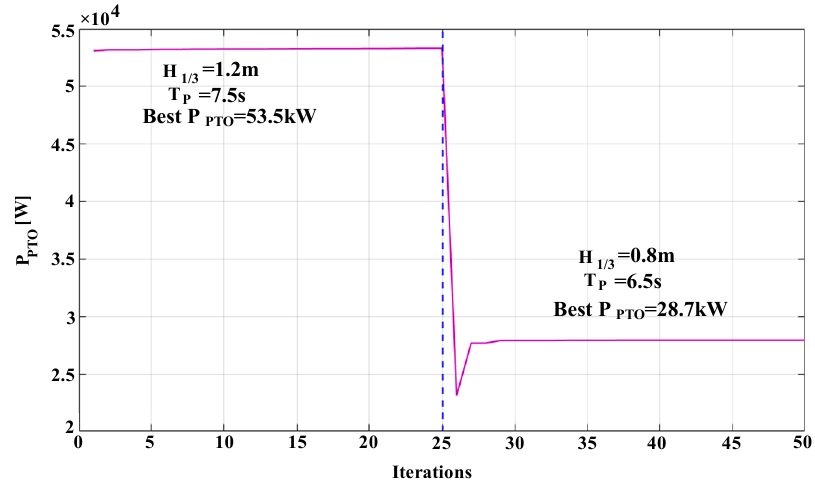
Figure 12. Simulated power search in case of a sudden change in sea state.